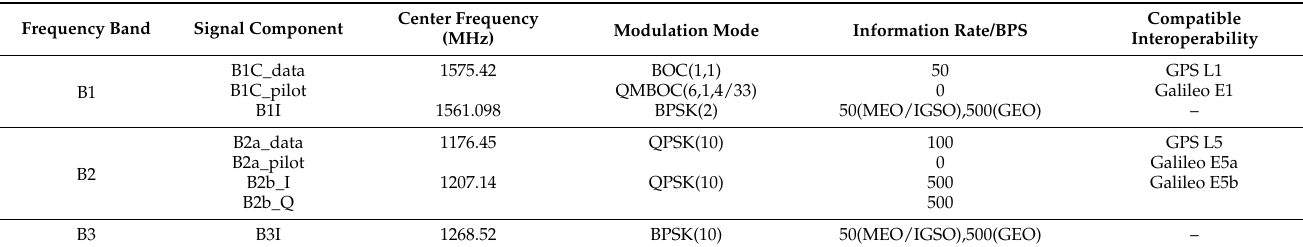
Table 1. Signal characteristics of BDS-3 open service